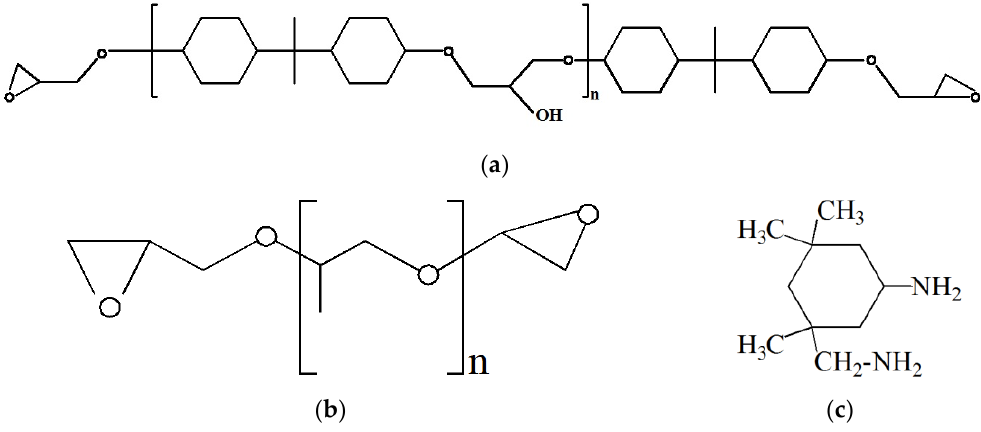
Figure1. The chemical structures of the AL-3040, JH-230, and IPDA: ( a ) hydrobisphenol A epoxy resin (AL-3040); ( b ) polypropylene glycol diglycidyl ether (JH-230); and ( c ) isophorone diamine (IPDA).